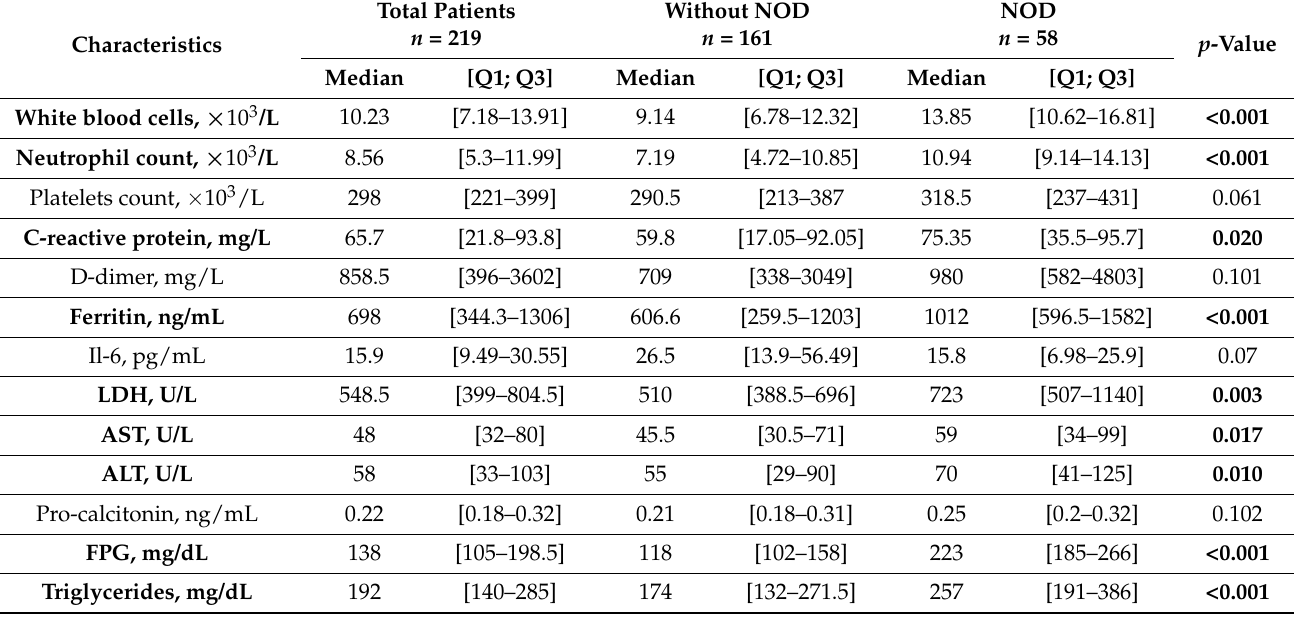
Table 3. Laboratory findings during hospitalization (days